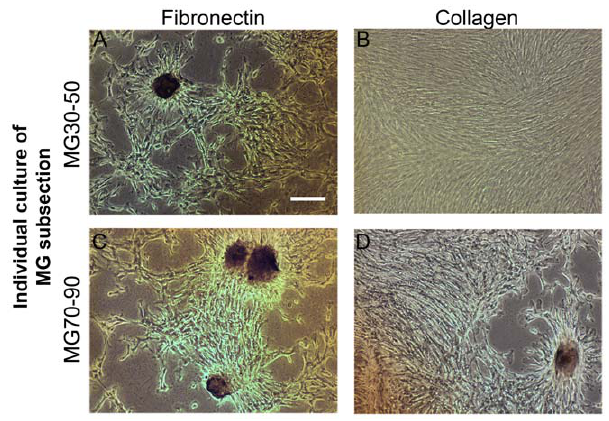
Figure 4. Differentiation on individual cultures of the gradient subsections. (A, C) Similar to MG10–90 substrates, osteogenic plaques were visualized on subsections of the fibronectin substrates. (B, D) Morphologically, on the MG30–50 substrate cells appeared similar to the corresponding region of the MG10–90 collagen substrate. However, osteogenic plaques were evident on the MG70–90 substrate. Scale bar represents 100 m m.